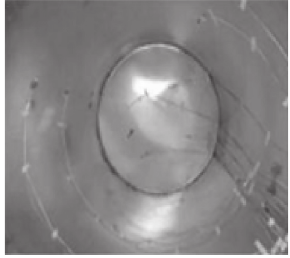
Figure 5: Cylindrical shell measurement nodes.